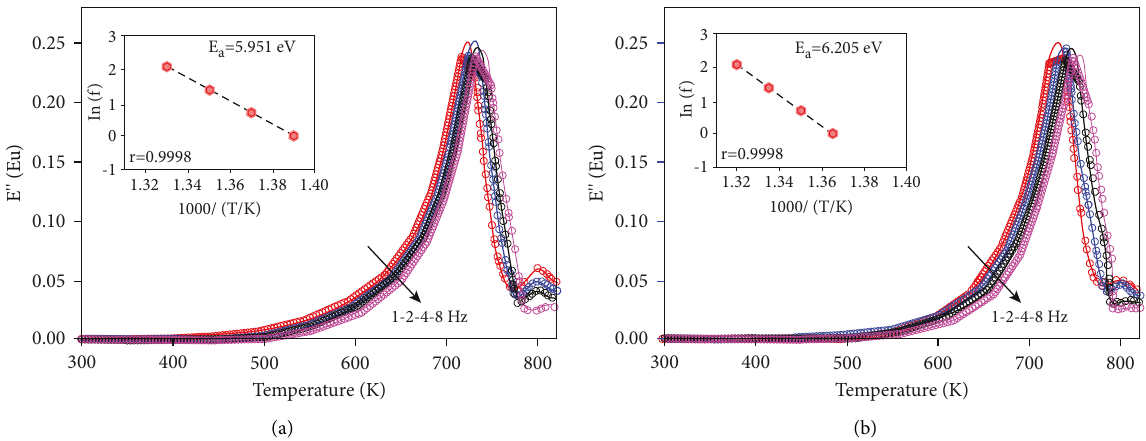
Figure 3: Temperature dependence of normalized loss modulus for different frequencies in (a) ZrCoAl and (b) ZrCoAlNi. The inset shows the estimation of activation energy by fitting driving frequency and temperature.